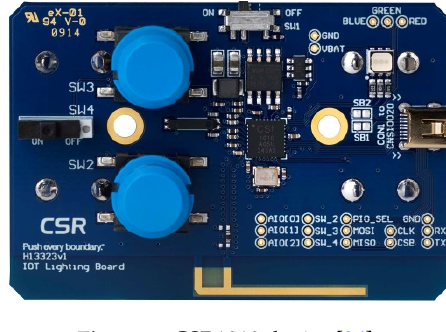
Figure 8. CSR1010 device